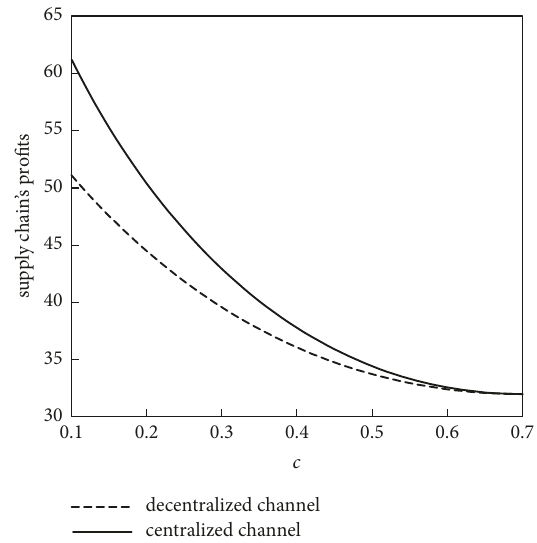
Figure 7: Order quantities under different marginal production costs.